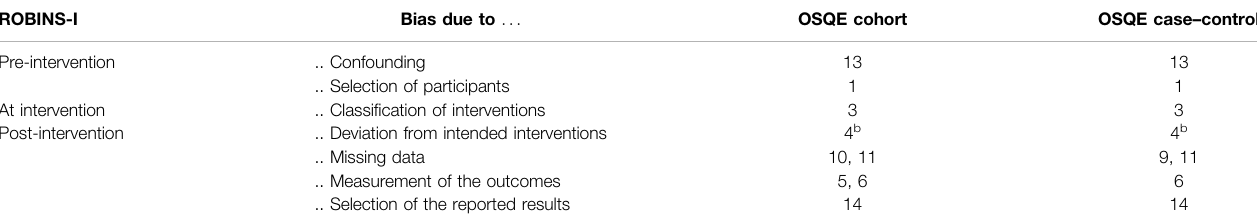
TABLE 3 | Comparison between ROBINS-I and OSQE. Section A: Overlap between ROBINS-I and OSQE a . ROBINS-I Bias due to